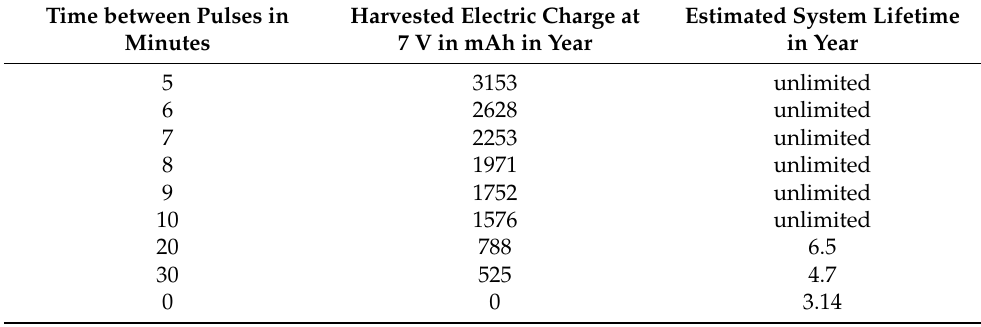
Table 6. Estimated system lifetime as function of the pulse